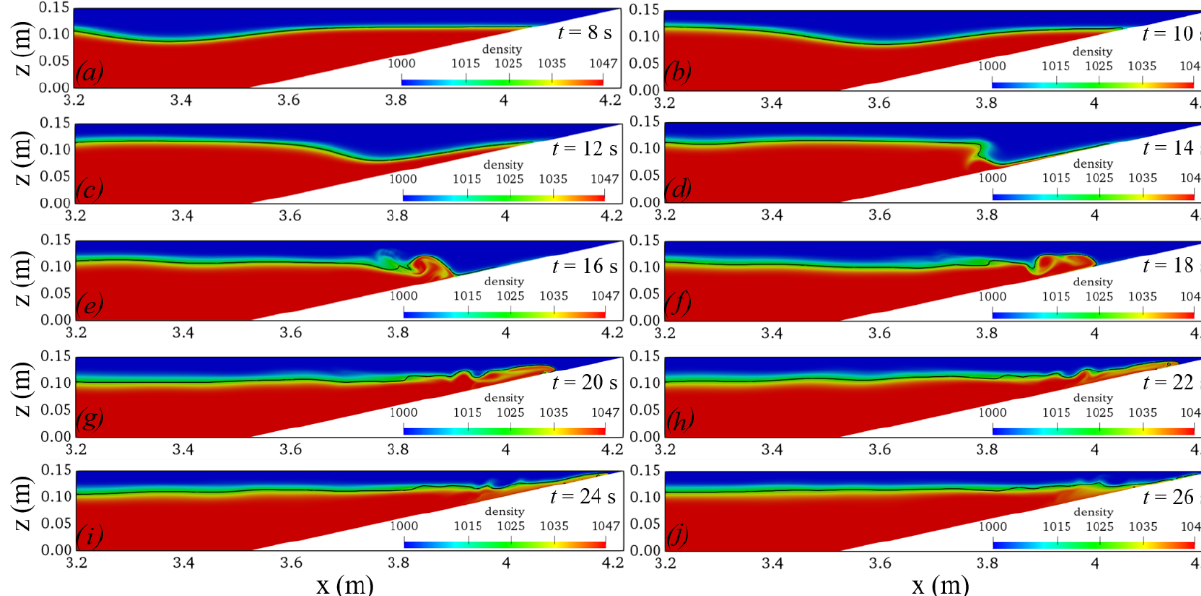
Figure 15. Temporal and spatial variations in the ISWs breaking calculated using ISWFoam (the black line represents the waveform).